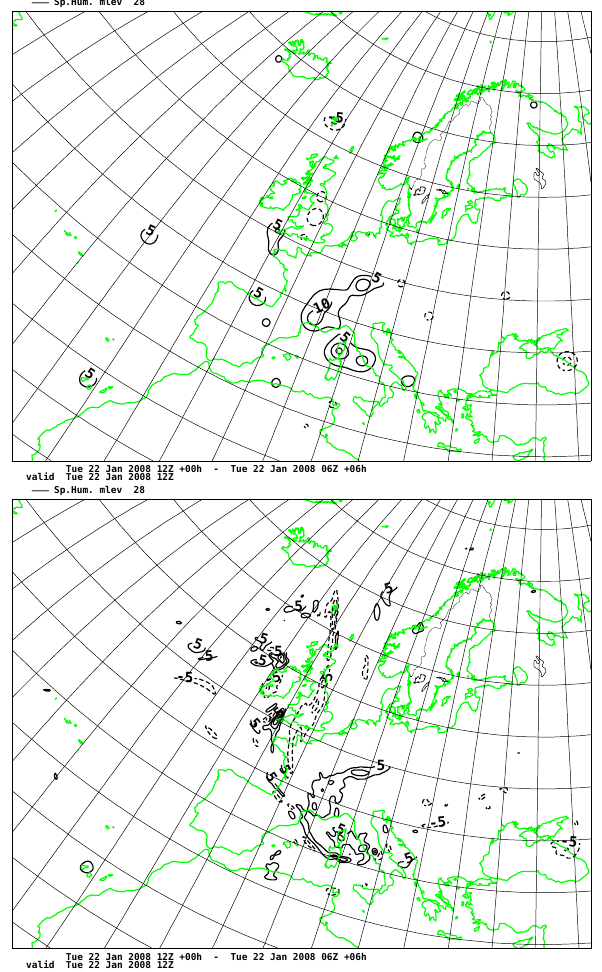
Fig. 10. Specific humidity assimilation increments at model level 30 ( ≈ 850 hPa) with 3D-Var (top) and with 3D-Var Hybrid (bottom). 22 January 2008 12 UTC. Isoline spacing 0.0005.